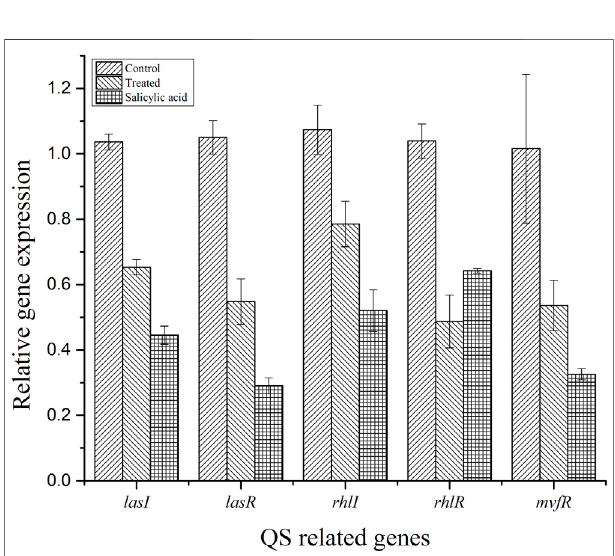
FIGURE8| EffectofBG138(12 μ g/ml),ontheselectedQS-relatedgene expressions ( lasI , lasR , rhlI , rhlR , and mvfR ) of P. aeruginosa PA2. DMSO and SA were used as